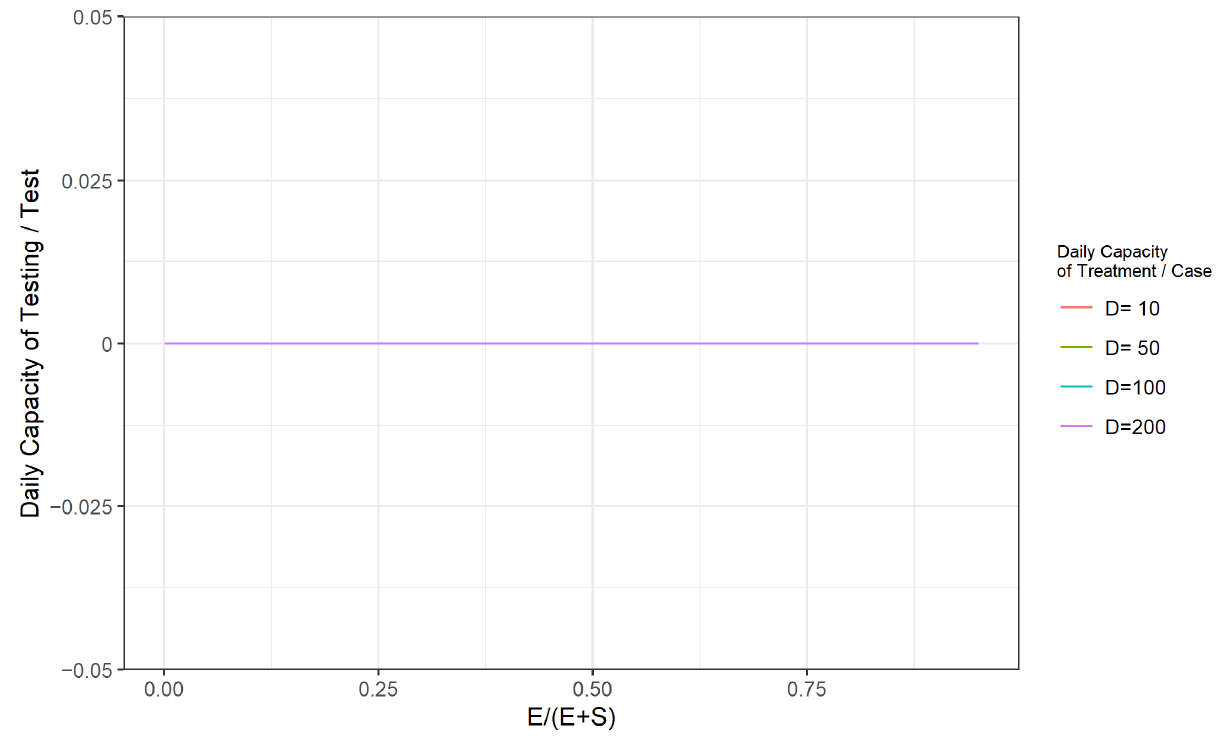
Figure A17. Relationship between the daily testing capacity of the epidemic and the potential level of the epidemic development ( S + E = 3000, I = 1000).